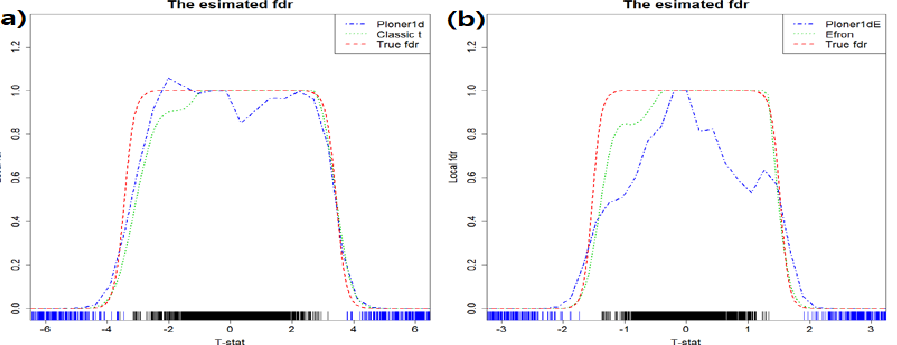
Figure 3. Basic scenario and two-sided. Estimated fdr1ds by using classic t -statistic ( a ) and modified t ( b ). As a reference, true fdr1d is provided in